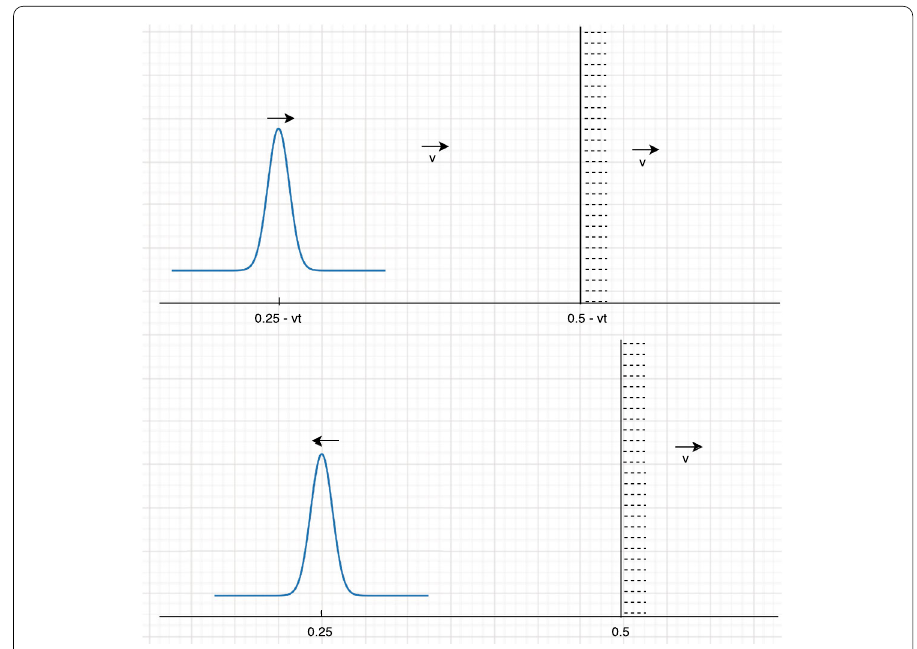
Fig. 3 One-dimensional acoustic wave setup: The figure at top depicts the initial position of the acoustic wave and the wall. Here v denotes the velocity of the wall, which is set to v = 0 . 01. The domain to the right of the wall is penalized. The amplitude of the pulse is (cid:12) = 10 − 3 . Bulk of the fluid moves along with the wall at velocity v . The figure at the bottom shows the final position of the wall and the pulse after t = 0 . 5 seconds. The pulse after reflection from the wall, has reached the position x = 0 . 25 and is seen to be travelling in the opposite